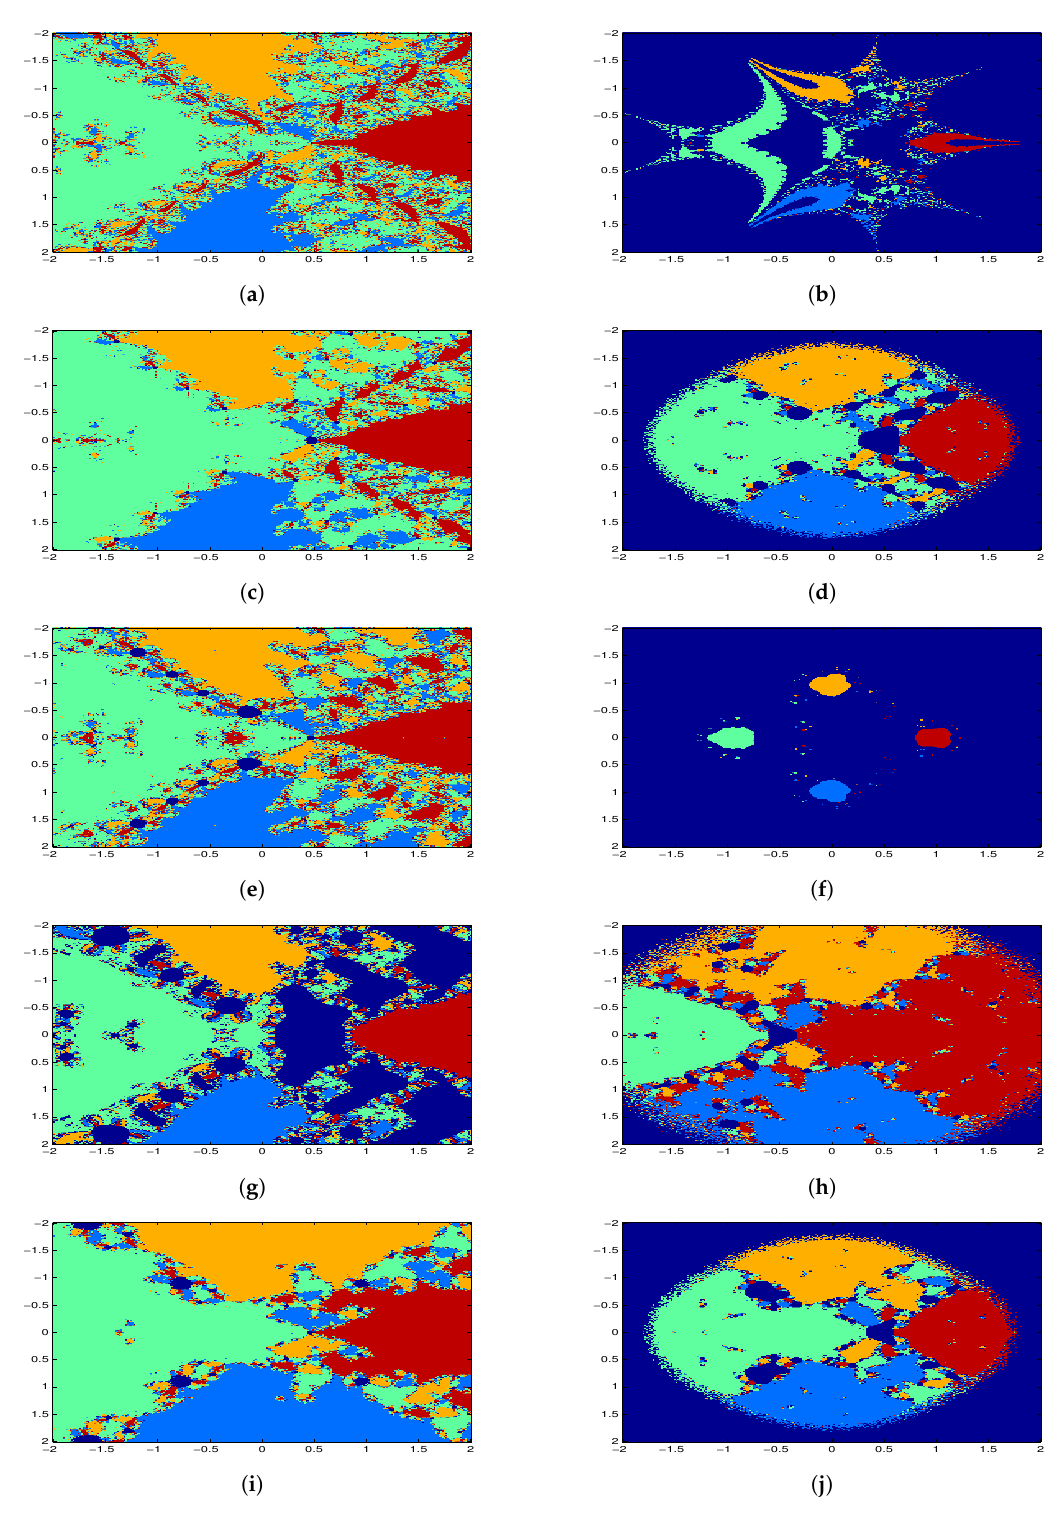
Figure 4. Polynomiographs of p 3 ( z ) : ( a ) KTM 4; ( b ) AKKB 4; ( c ) ZLM 4; ( d ) PM 4; ( e ) AKKB 8; ( f ) KBK 8; ( g ) SM 8; ( h ) PM 8; ( i ) ZLM 16; and ( j ) PM